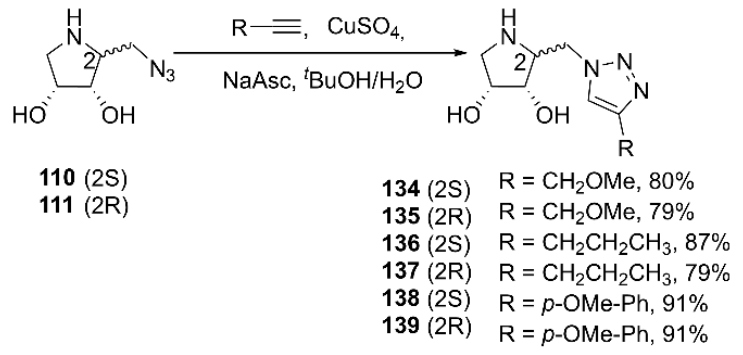
Figure 9 . Tri-, tetra-, hexa- and nonavalent iminosugars 114 – 133 .